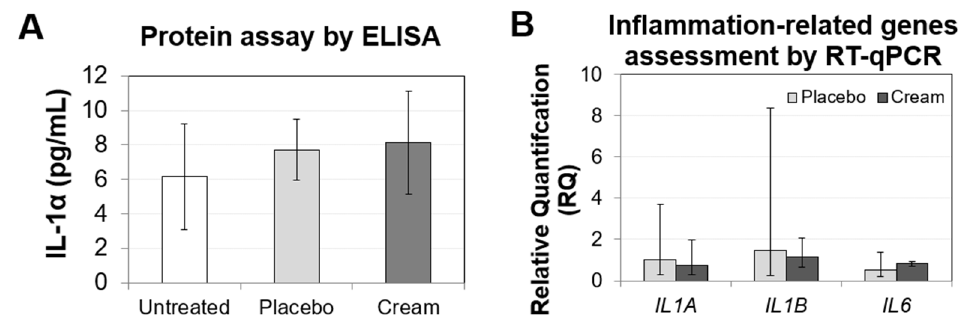
Figure 1. Assessment of the inflammation biomarkers on human skin explants after eight days of topical treatment. ( A ) IL-1 α ELISA from the untreated, placebo (negative control formulation), and cream (test product) samples. The results are shown as the mean (cid:3399) SD. ( B ) RT-qPCR results from the IL1A , IL1B , and IL6 genes, showing relative quantification compared to the untreated sample. RQmin and RQmax represent the 95% confidence levels. A t -test was performed to evaluate the statistical